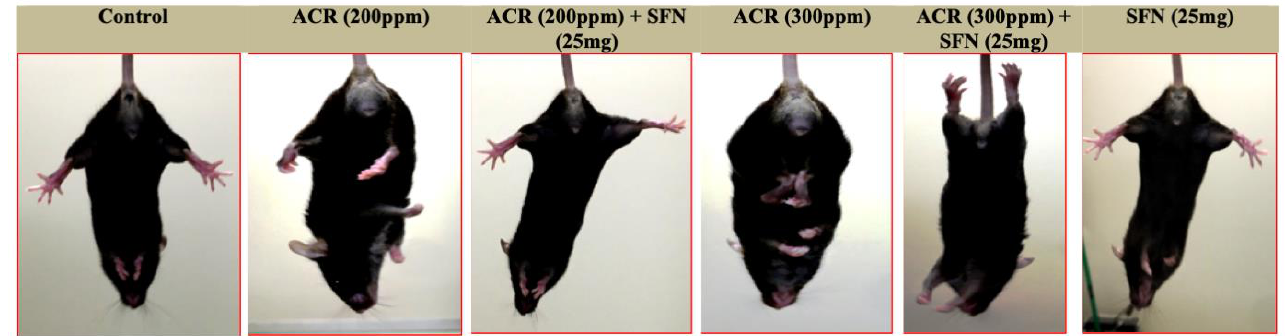
Figure 1. Representative images of mice showing various degrees of hindlimb clasping effect following exposure to acrylamide and sulforaphane for 4